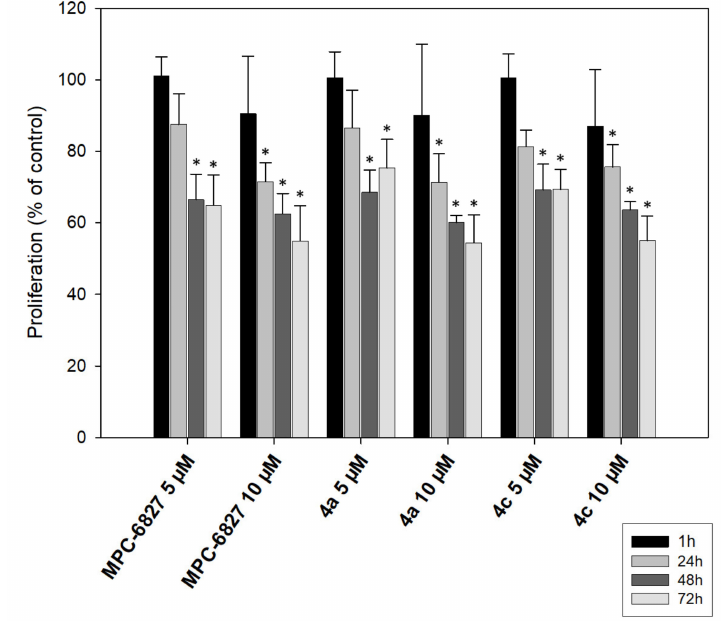
Figure 3. Proliferation of Caco-2 cells treated with MPC-6827 (5 and 10 µ M), 4a (5 and 10 µ M) and 4c (5 and 10 µ M) after 1, 24, 48 and 72 h of treatment. Proliferation was evaluated with an MTT assay. Data are reported as the mean ± SD in percentage from three independent experiments. * P < 0.05 vs. control that represented 100% of proliferation.